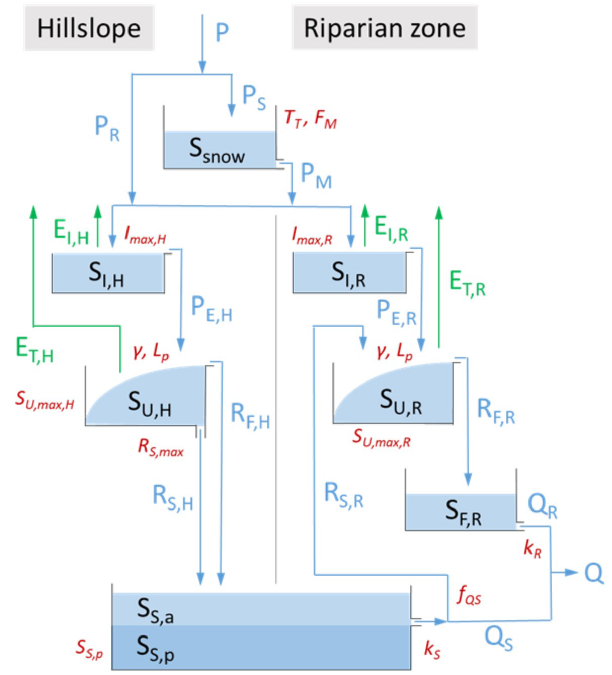
Figure 4. Model structure used in this study. The light blue boxes indicate the hydrologically active individual storage volumes in the hillslope and riparian zones, respectively. The darker blue box S S,p indicates a hydrologically passive, i.e. d S S,p / d t = 0, mixing vol- ume. The blue lines indicate liquid water fluxes, and the green lines indicate vapour fluxes. Model parameters are shown in red adjacent to the model component they are associated with. All symbols are defined in Table